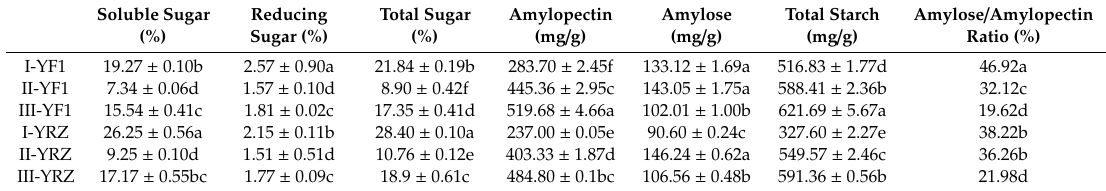
Table 1. Analysis of significant di ff erences in sugar and starch contents.